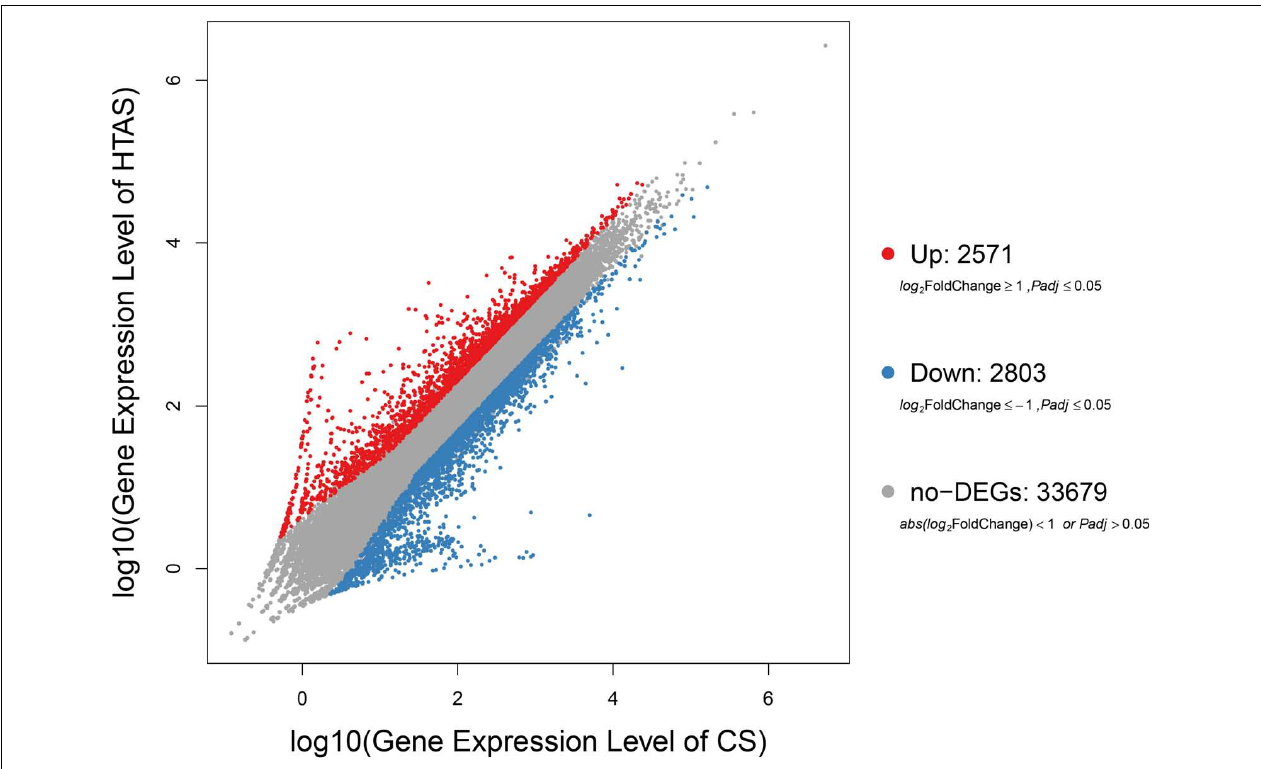
FIGURE 1 | Expression levels in HTAS vs. CS female adults. The variability pattern was displayed by volcano plot. Red points, blue points, and gray points represent up-regulated genes, down-regulated genes, and non-differentially expressed genes, respectively. The horizontal coordinate indicates expression level in CS female adults, while the vertical coordinate indicates expression level in HTAS female